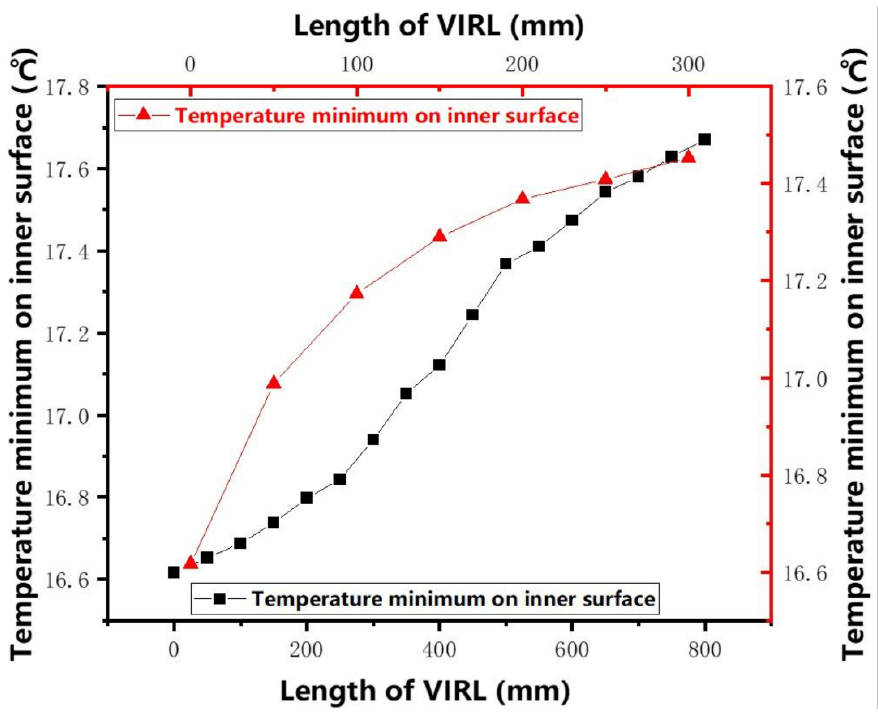
Figure 11. Height and thickness of the VIRL in relation to the minimum ground temperature. Table 8. Comparison of Group F models with other optimal models. Temperature Condition No. Minimum on